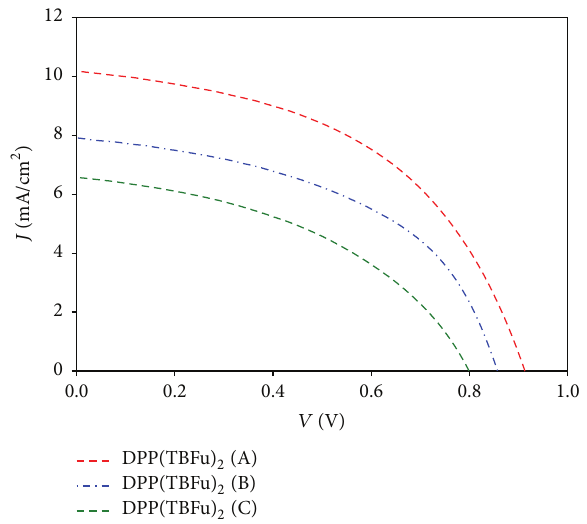
Figure 6: 𝐽 - 𝑉 curves of the gradually annealed (at highest PCE) solar cells with MoO 3 as an anode